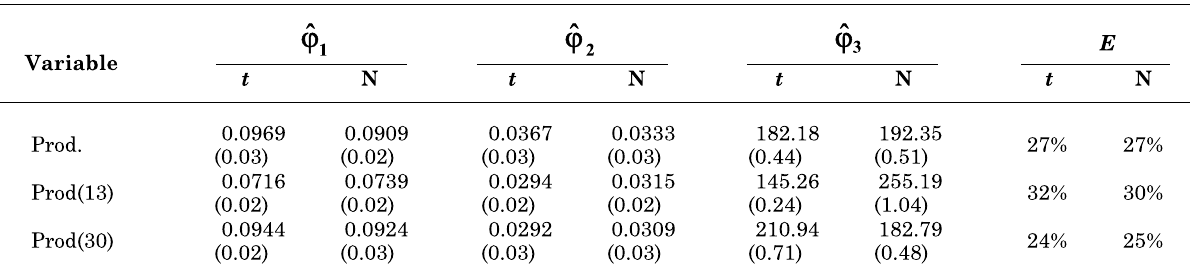
Student’s t -distribution with v = 3, N: normal distribution; In brackets, the standard deviations of each parameter estimated. E (%) = ϕ /( ϕ + ϕ ): coefficient of relative nugget 2 1 2